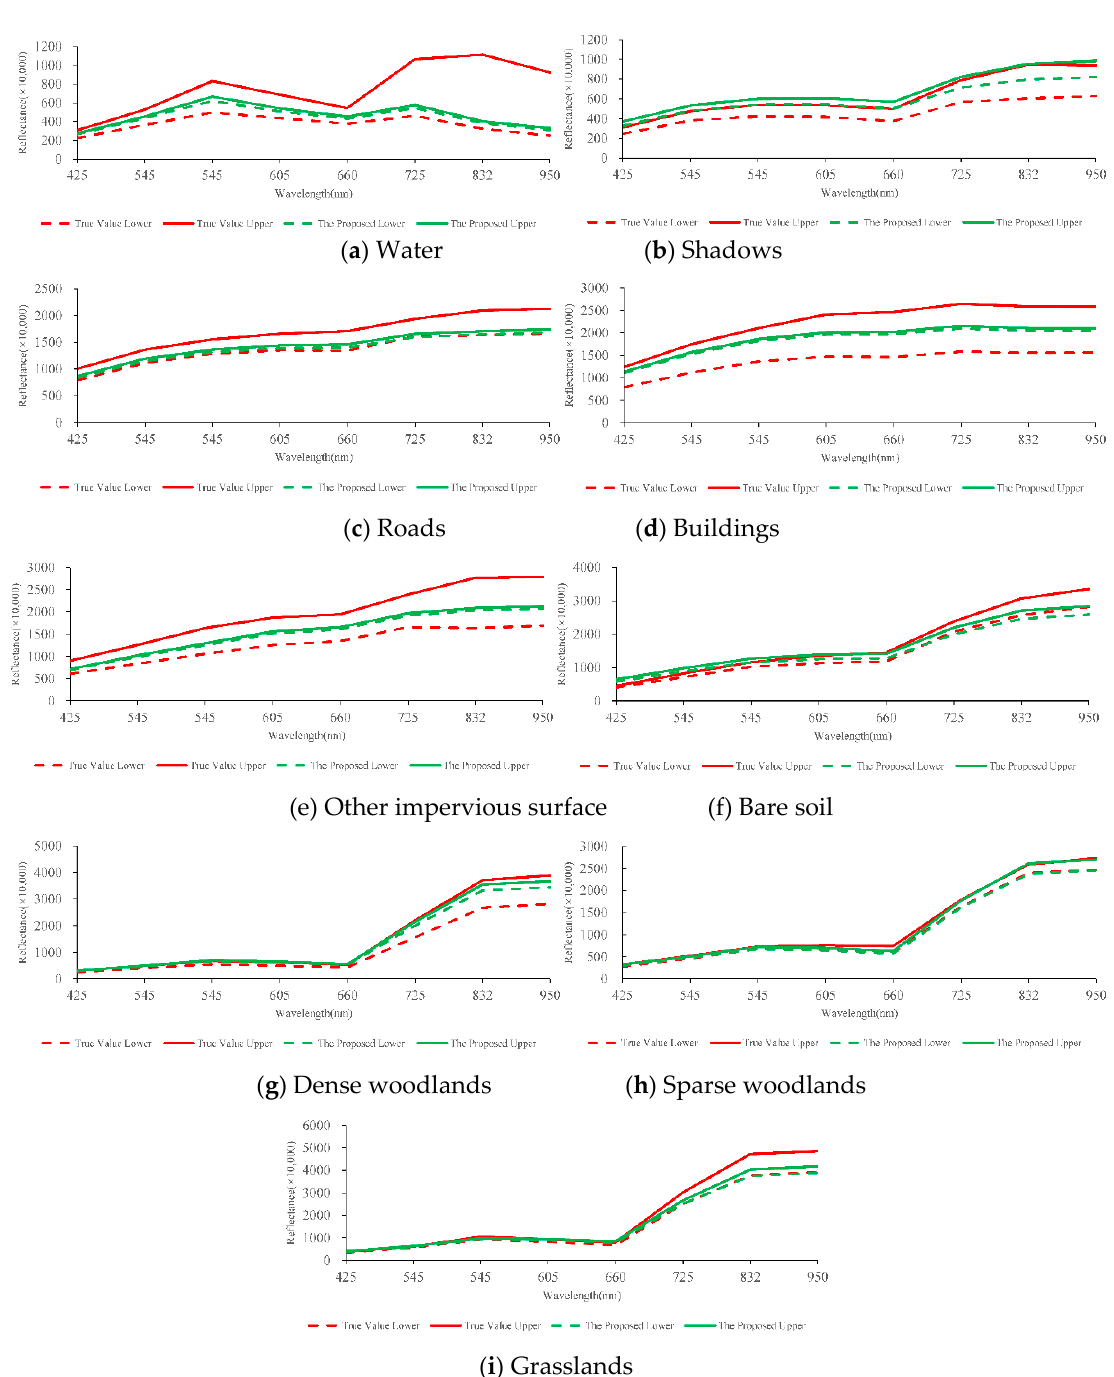
Figure 14. The banded spectral curves of true value and spectral curves modeled by hierarchical SSW-IT2FCM-O (wavelength: nm). The x-axis is the wavelength, and the y-axis represents the reflectance for a scale factor of 10,000.